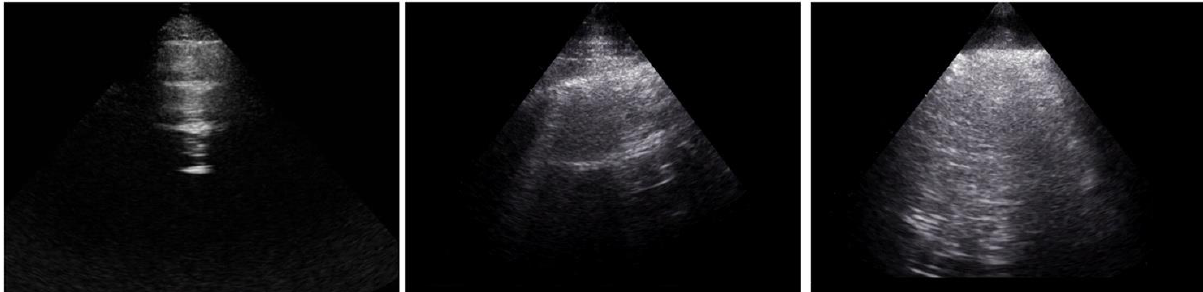
Figure 1. Example of normal LUS ( left panel ), LUS with 1 B-line ( central panel ) and with multiple B-lines ( right panel ).